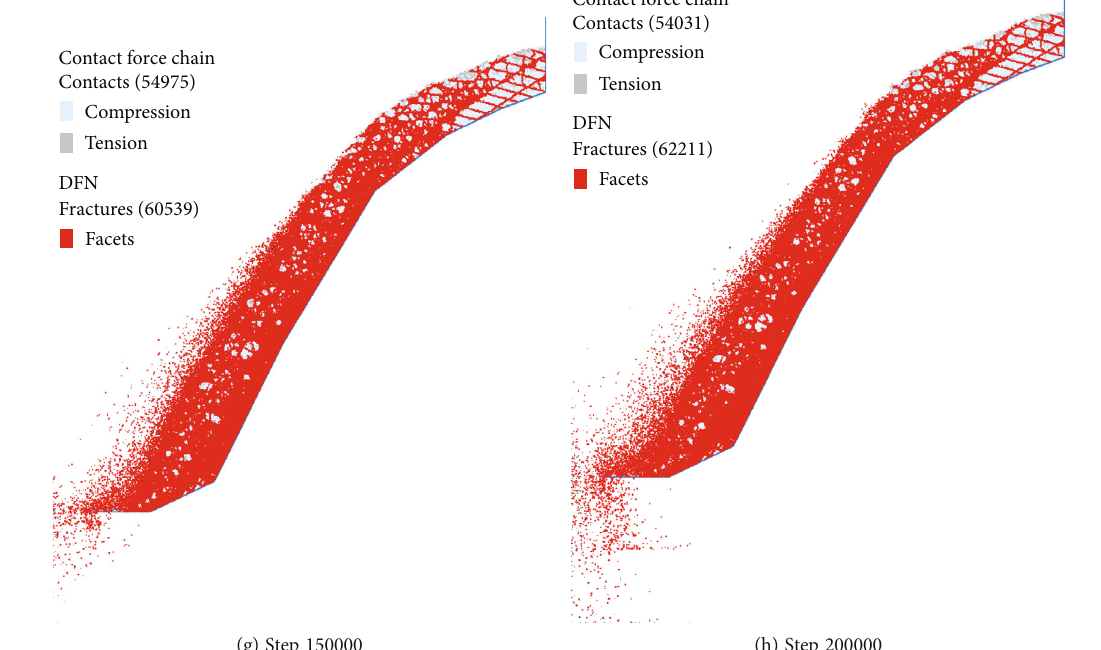
Figure 7: The dynamic collapse process of the typical section.